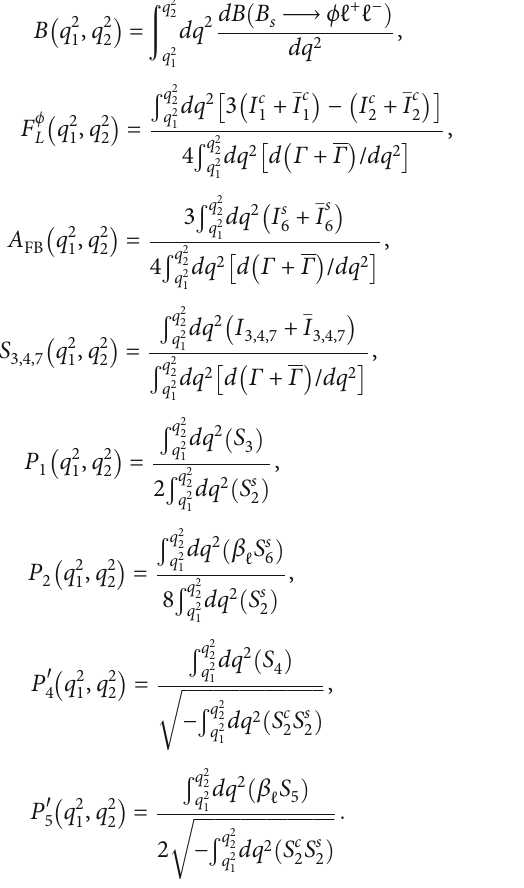
Table 8: Theoretical predictions for the q 2 -binned observables B ð B +Lattice ” (the second row) approach, respectively. For a comparison, we also list the new LHCb measurements [33]. q 2 bin GeV 2